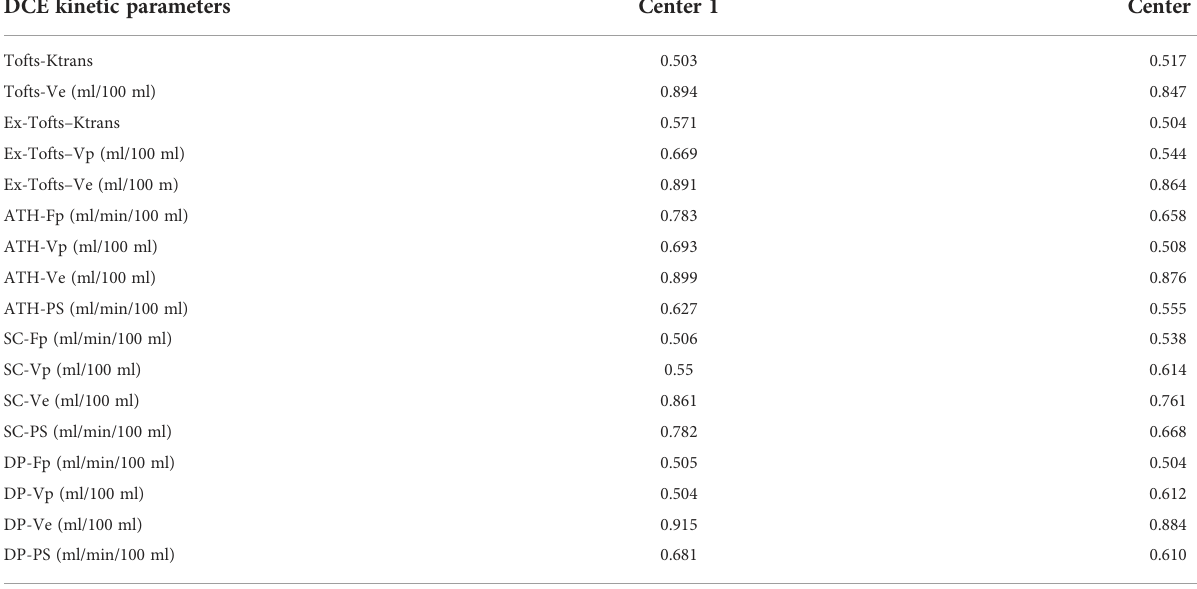
TABLE 4 AUC values of DCE kinetic parameters derived by various models in differentiating cervical carcinoma tissue from normal cervix tissue in the three centers. DCE kinetic parameters Center 1 Center